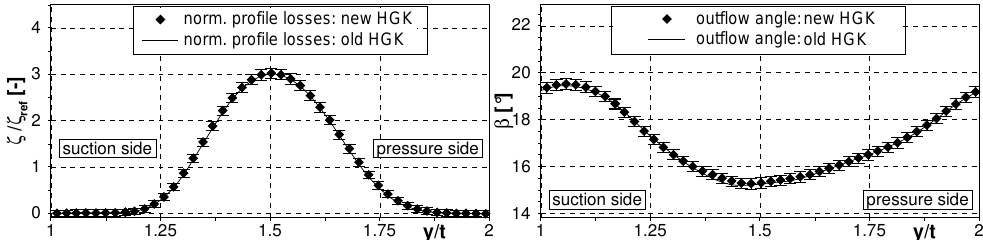
Figure 11. Profile loss characterization ( left ) and outflow angle measurements ( right ) on a transonic turbine cascade, before and after